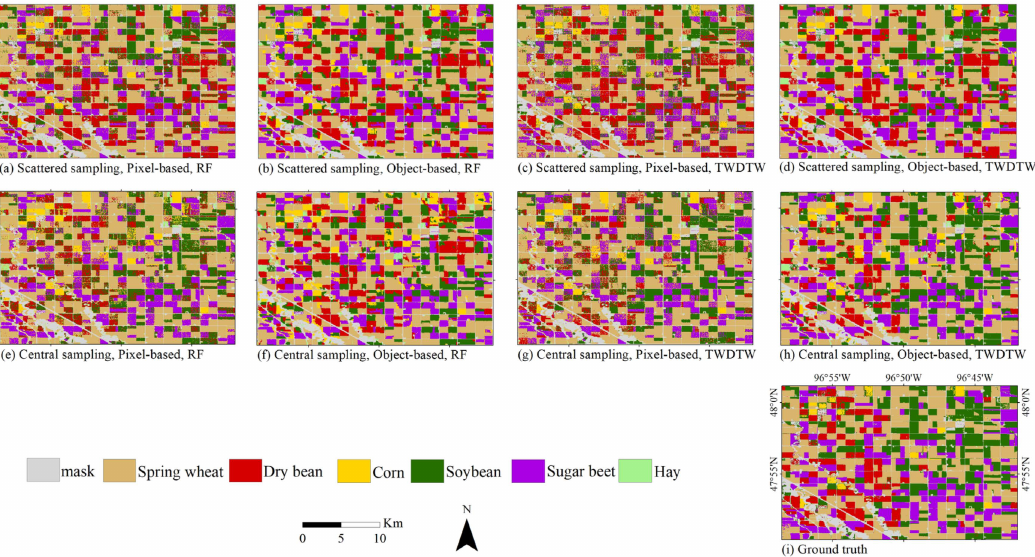
Figure 8. Crop classification results in the zoom area under different sampling strategies, perspectives, and classifiers. RF and TWDTW are the abbreviations of Random Forest and Time-Weighted Dynamic Time Warping, respectively.